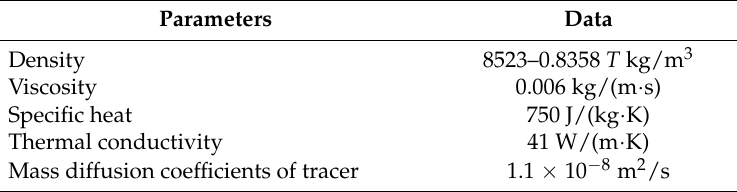
Table 6. Physical properties of molten steel [23].